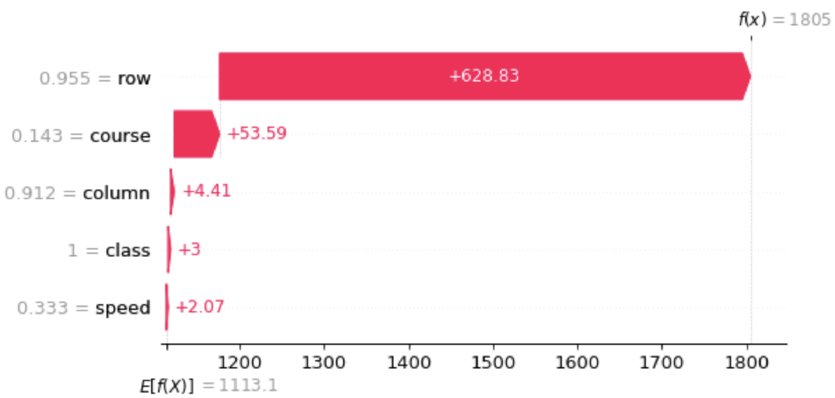
Figure 7. The contribution of each input feature to build the output predicted by KNN for ship 26.